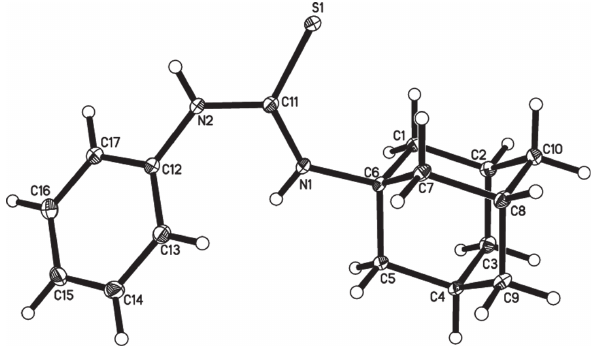
Table 1: Data collection and handling.